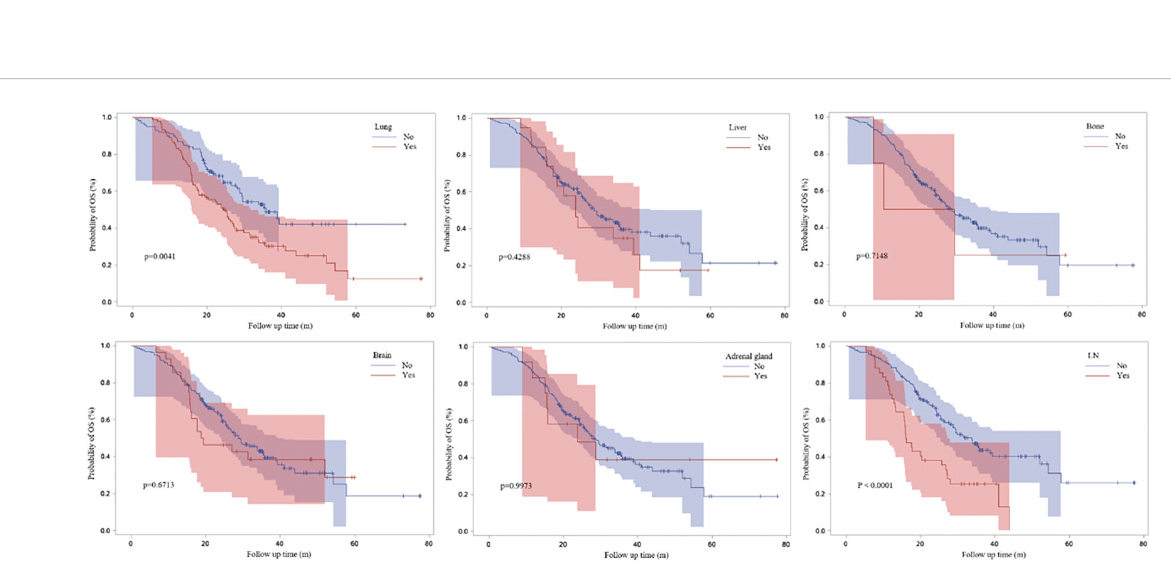
FIGURE 8 Survival curves based on Kaplan-Meier for different progressive